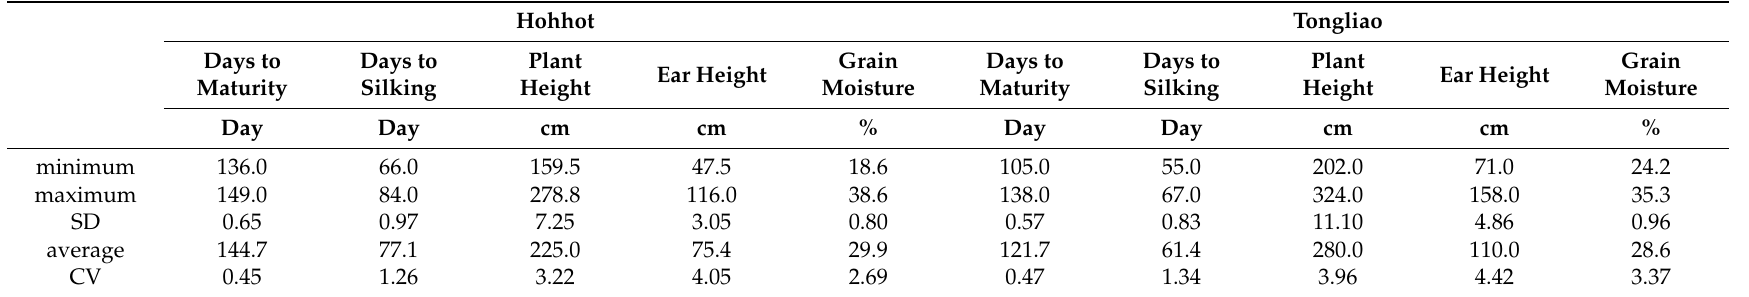
Table 6. Summary of machine-harvesting-related trait measurements for 64 maize hybrids grown in Hohhot and Tongliao in 2015. Hohhot Tongliao Plant Moisture Silking Height